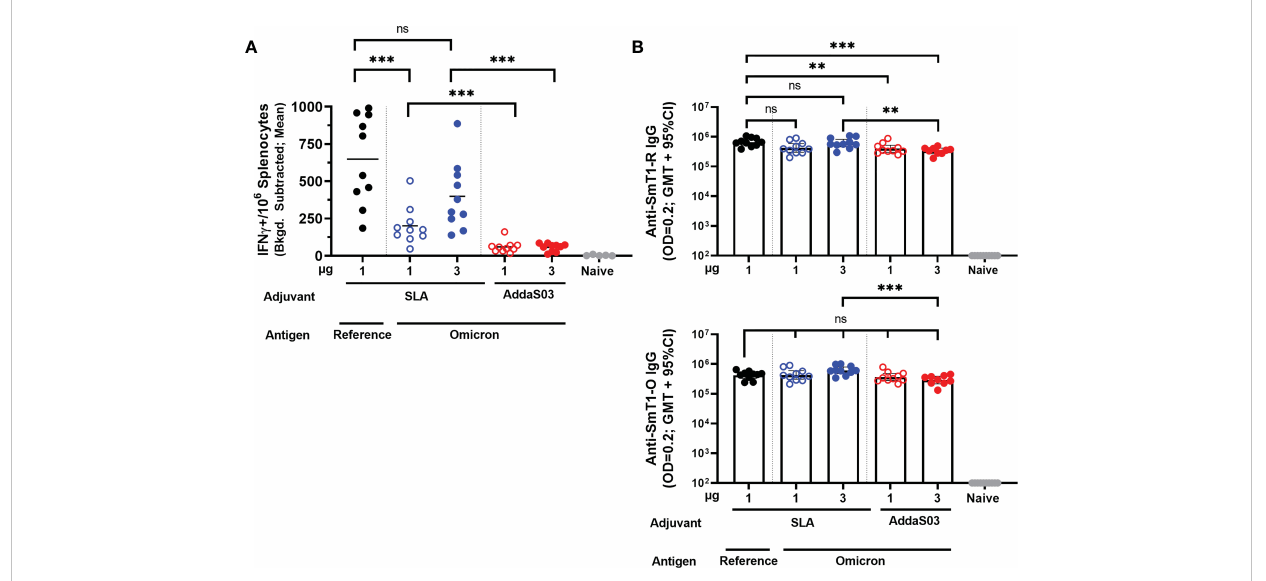
FIGURE 2 Adjuvanted formulations of SmT1-O and SmT1-R elicit cellular and humoral antigen-speci fi c immune responses. C57BL/6 mice (n=10/group) were immunized i.m. with SmT1-R or SmT1-O adjuvanted with SLA or AddaS03 on days 0 and 21. (A) Splenocytes were harvested on Day 28 and analyzed by IFN- g ELISpot when stimulated by spike peptide pools. Values obtained with media alone were subtracted from those measured in the presence of the peptides. Grouped data are presented as a mean. (B) Serum was also collected on Day 28 and analyzed by ELISA against SmT1-R (top graph) and SmT1-O (bottom graph) to determine the antibody titers on Day 28. Grouped data are presented as geometric mean + 95% con fi dence interval. In all graphs, statistical signi fi cance of differences is shown as: ns = not signi fi cant, ** p < 0.01 and *** p < 0.001 by one-way ANOVA followed by Tukey ’ s multiple comparisons test when compared to the other adjuvant with an equivalent dose of SmT1-O or the SmT1-R containing